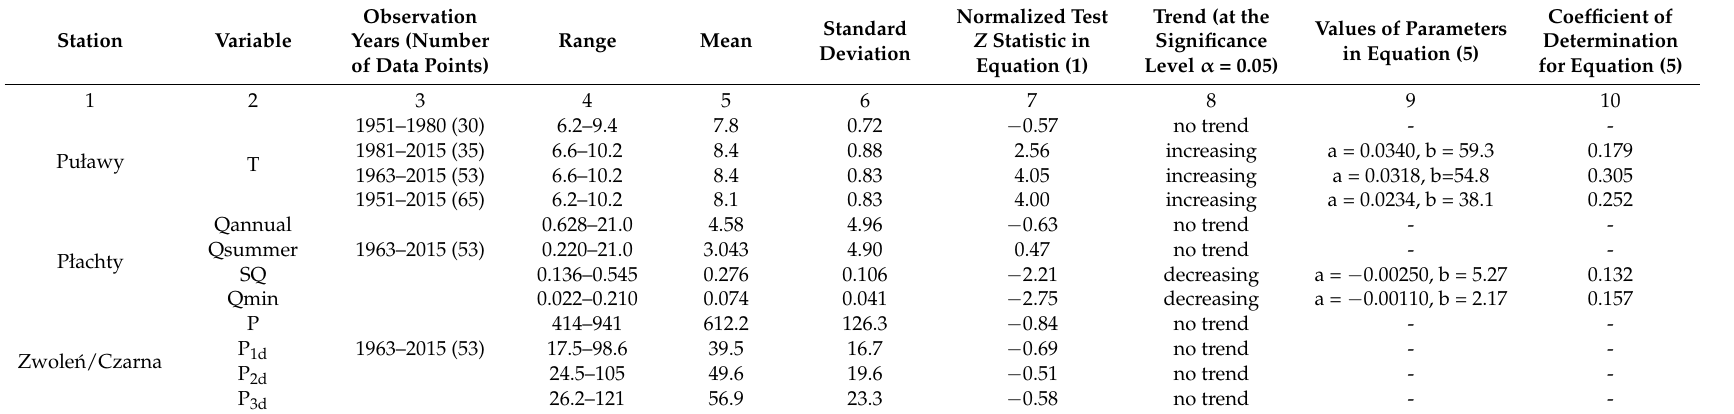
Table 1. Statistics of the analyzed hydro-meteorological